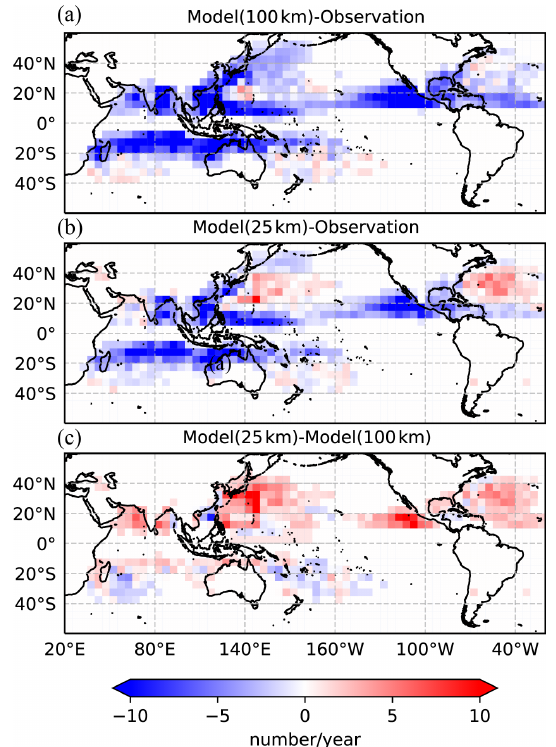
Figure 2. Global track density anomalies of tropical cyclones. The track density is analyzed in (5 ◦ × 5 ◦ ) equidistant grid boxes at 6h intervals and the unit of the color map is the number of cyclones per year from 1991 to 2014. (a) Track density anomaly between FGOALS-f3-L and IBTrACS; (b) track density anomaly between FGOALS-f3-H and IBTrACS; and (c) track density anomaly be- tween FGOALS-f3-H and